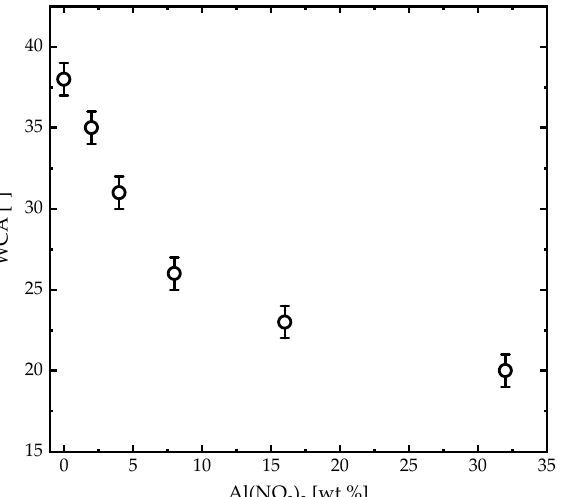
Figure 4. Water contact angles of (PANI-HCl)/Al(NO 3 ) 3 complex composite films as a function of Al(NO 3 ) 3 concentration.